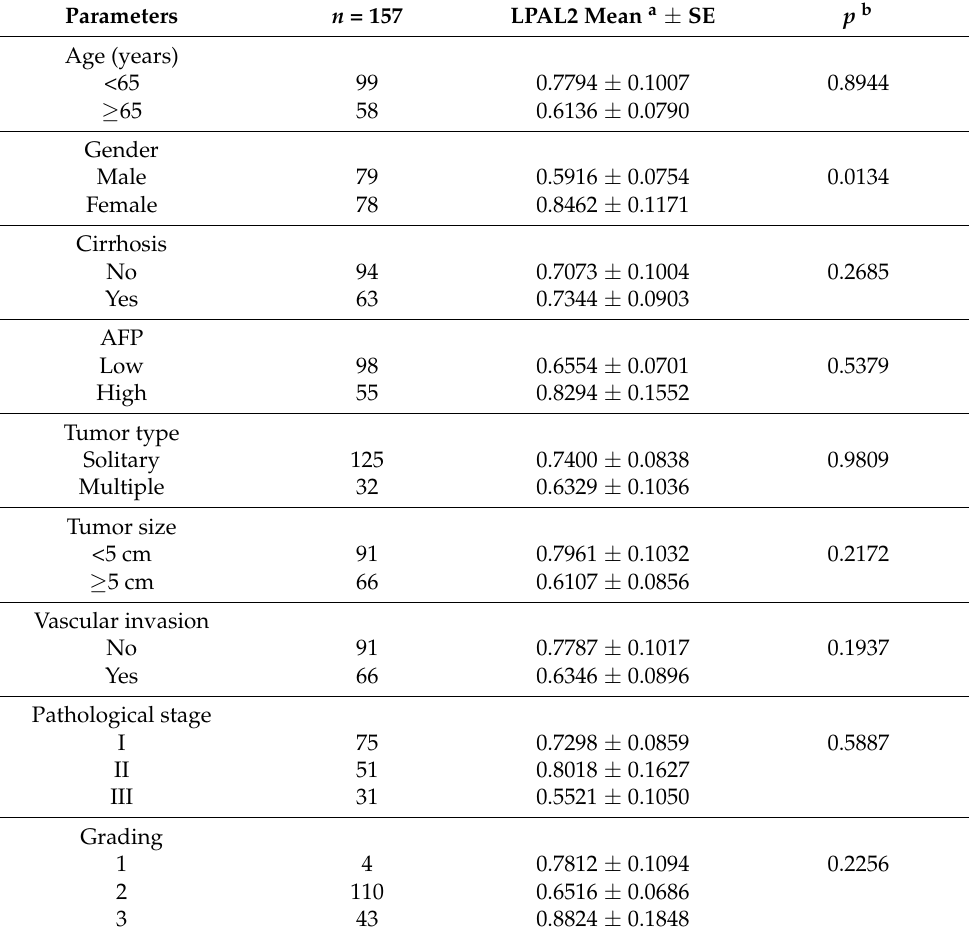
Table 1. Clinicopathological correlations of LPAL2 in HCC